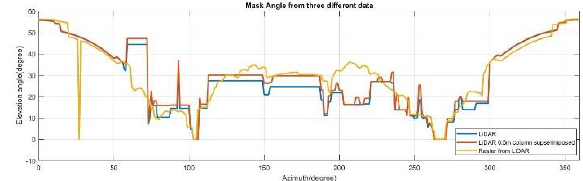
Figure 19. Point A’s mask angle from three different dataset